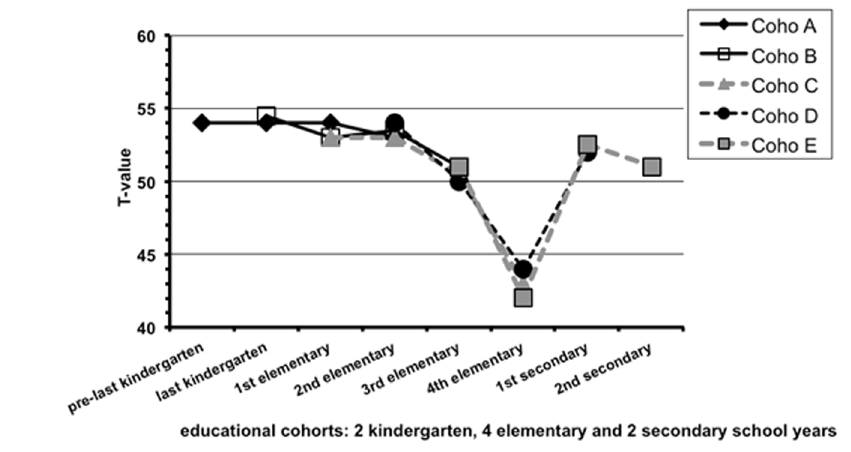
Figure 1. Cross-sequential results on self-esteem (SEL) in the German sample.